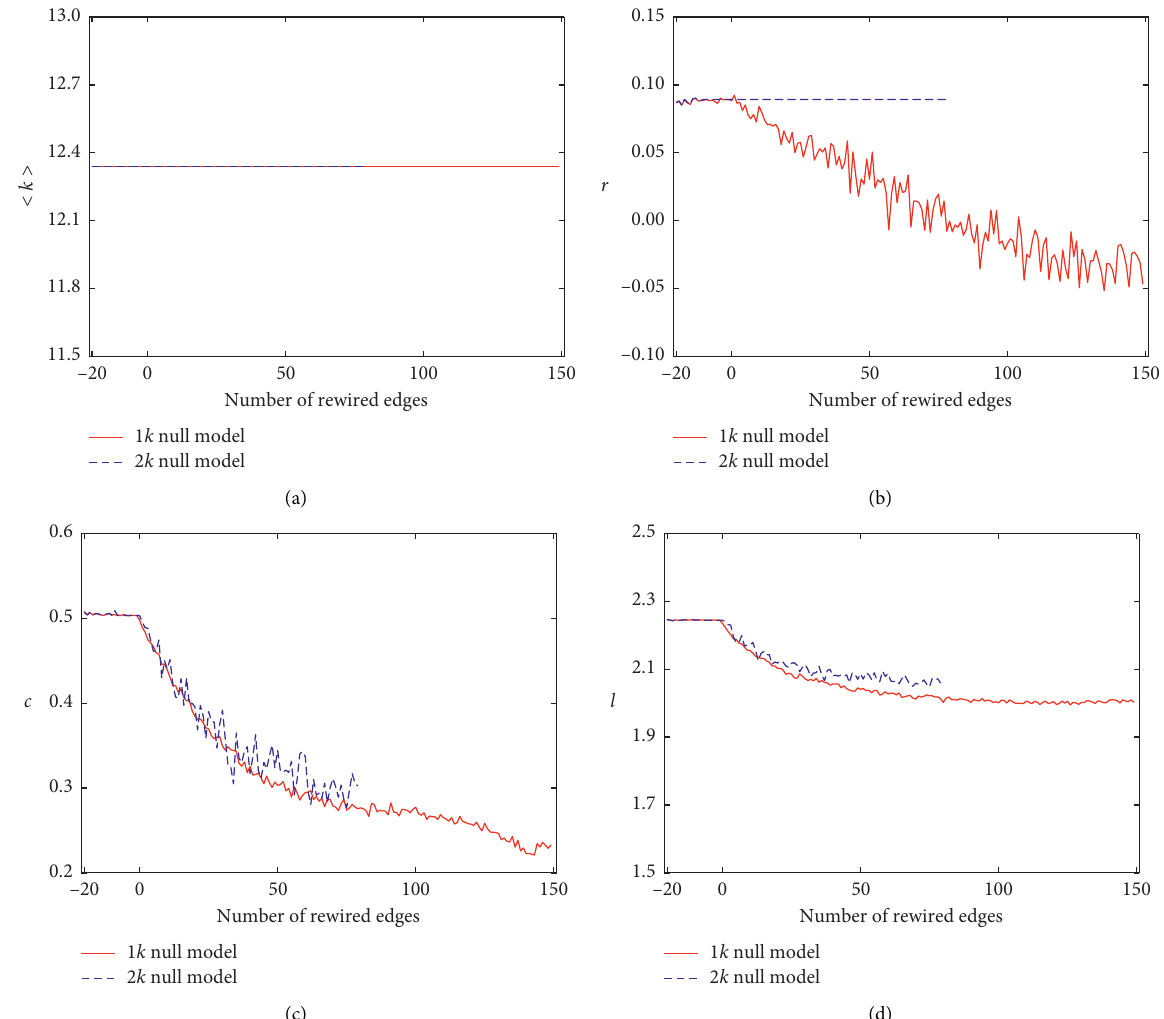
Figure 9: Structural characteristic of the benchmarks generated based on the anatomical connection network of the macaque cortex, including average degree < k > , assortativity coefficient r , clustering coefficient c , and average shortest path length l . Red lines correspond to the benchmarks generated based on the 1 k null model, and blue lines correspond to the benchmarks generated based on the 2 k null model. The negative and positive values of the abscissa represent the number of rewired edges when the community structure is strengthened and weakened,